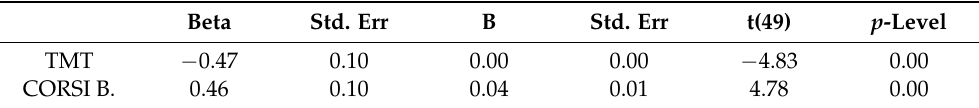
Table 1. The table shows the relationship between participants’ performance at both TMT and Corsi Backward as predictors and accuracy of egocentric judgments as criteria. The parameters of predictors of the outcome variable are